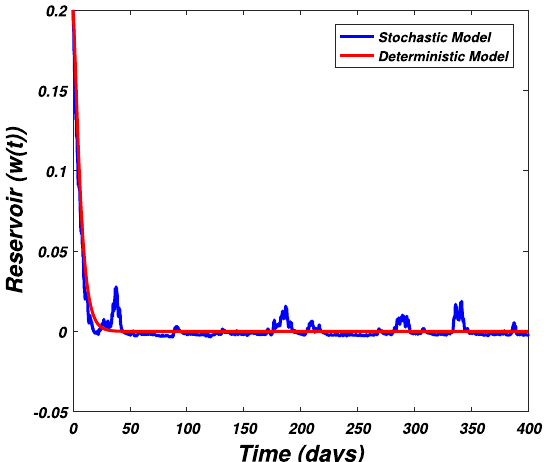
Figure 9. The graph visualizes the time dynamics of the reported model (1) in case of extinction for the reservoir ( w ( t )) subject to the parametric values of S 1 and (0.5, 0.3, 0.2, 0.1) initial populations.